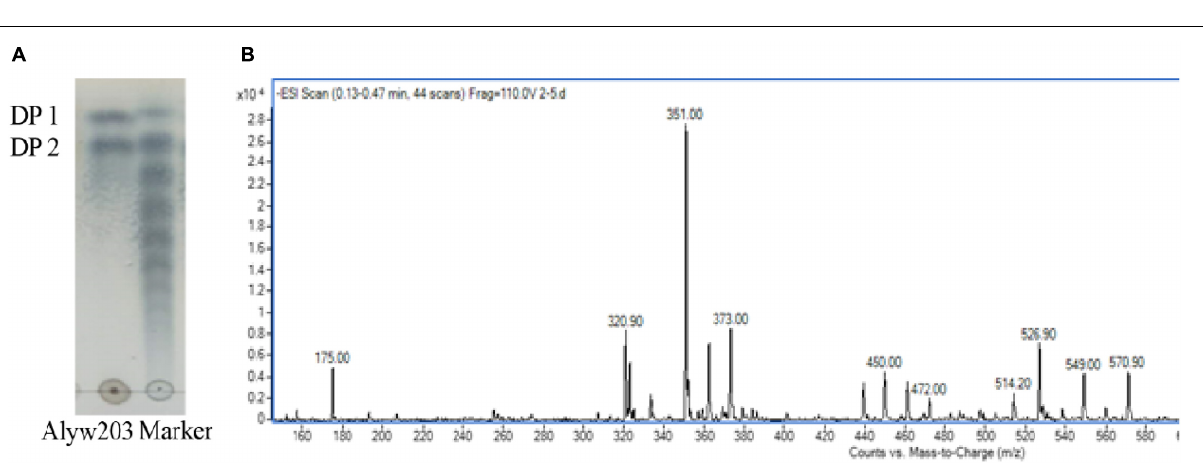
electrospray ionization mass spectrometry, Figure 8B ) analysis further proves that these two spectra correspond to the Mws of unsaturated alginate monosaccharides (175.00 m / z )